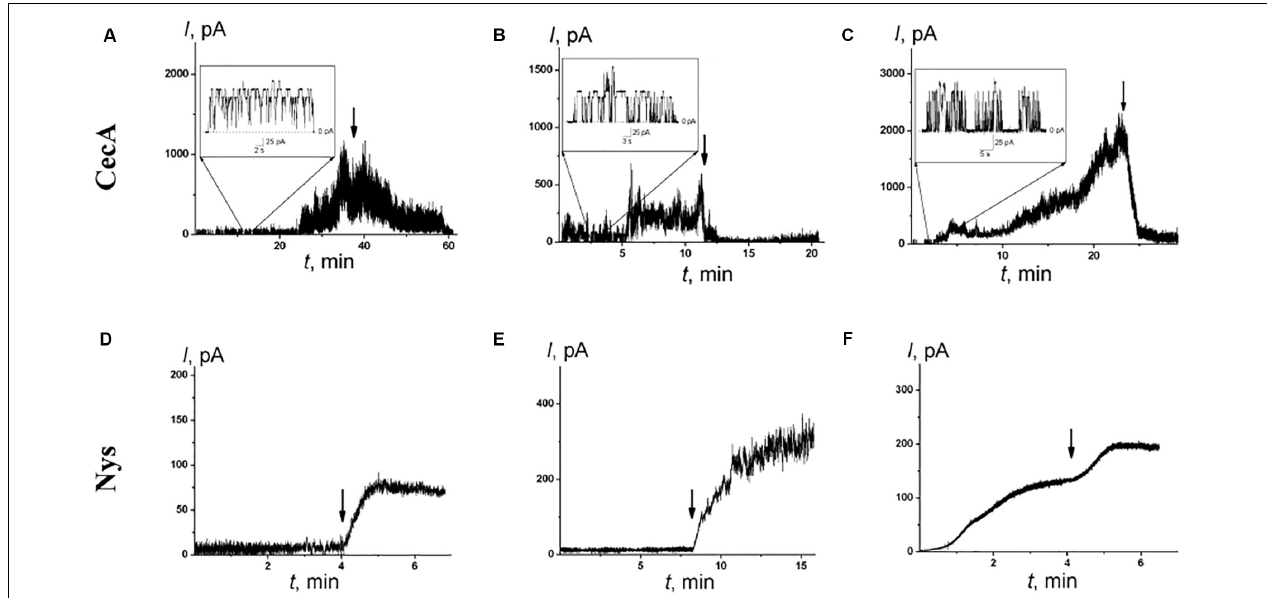
FIGURE 5 | The effects of alkaloids on the steady-state transmembrane current flowing through membranes modified by CecA (A – C) and Nys (D–F) . The moment of the addition of 0.4 mM piperine (A,D) , dihydrocapsaicin (B,E) , and capsaicin (C,F) to the bilayer bathing solution is indicated by an arrow. The lipid bilayers were composed of DOPS/DOPE (50/50 mol%) and bathed in 0.1 M KCl, pH 7.4 ( A–C ) or POPC/Chol (67/33 mol%) and bathed in 2.0 M KCl, pH 7.4 ( D–F ) . V = 50 mV. Inserts: Current fluctuations of single CecA